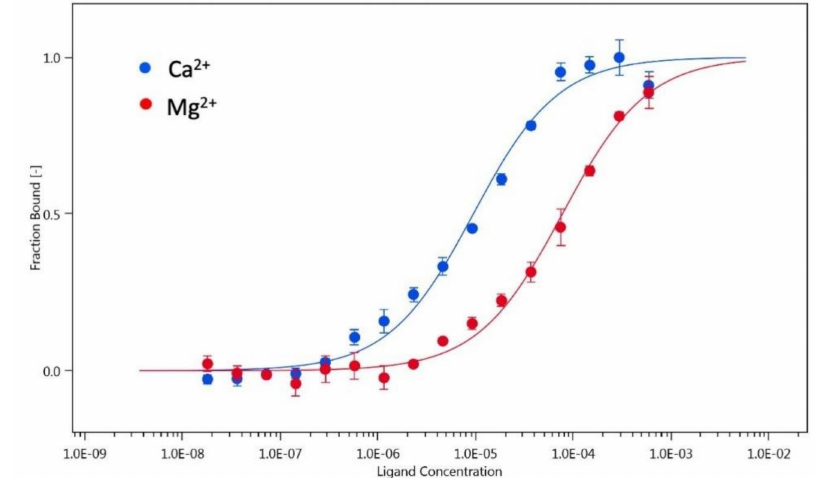
Figure 2. Microscale thermophoresis of the hGCAP1 monomer-dimer transition in Ca 2 + and Mg 2 + . Changes in labeled protein fluorescence as a function of unlabeled hGCAP1 concentration in the presence of Ca 2 + (blue points) or Mg 2 + (red points) together with the curves fitting the two experiments (law of mass action) in blue and red,